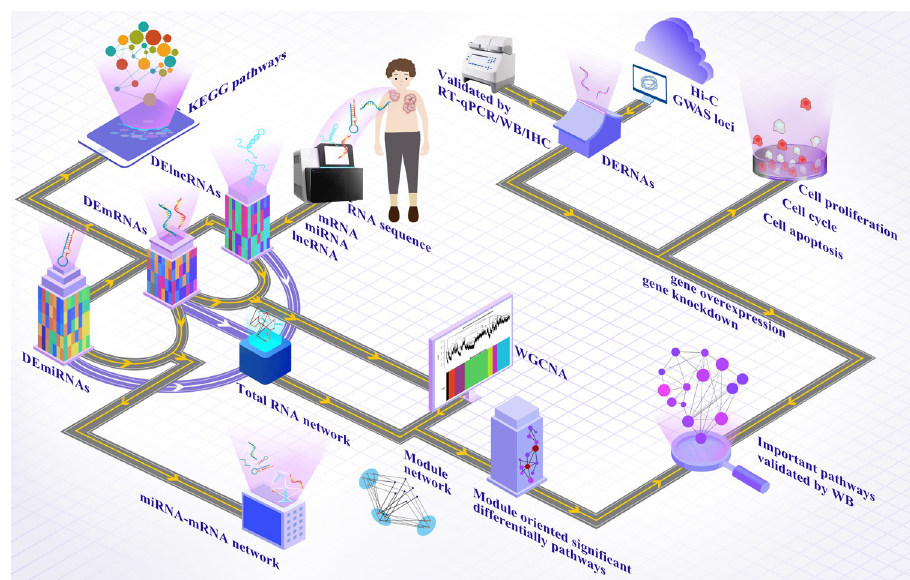
Fig 1. The flow chart of the